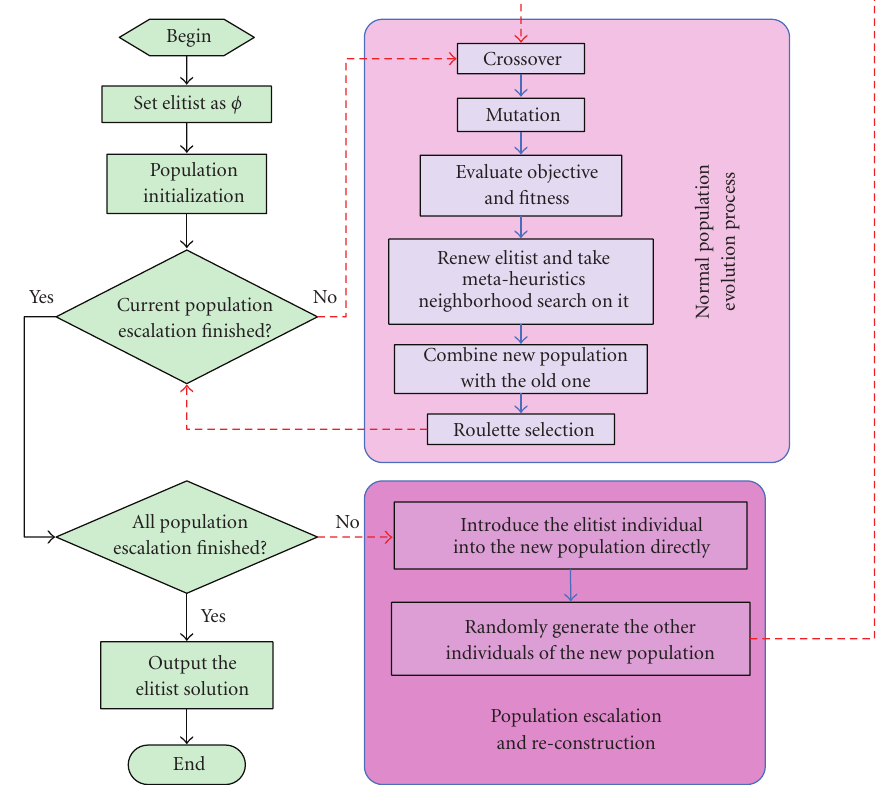
Figure 8: Flowchart of the Twin-screw Coded Evolutionary Algorithm (TCEA) for